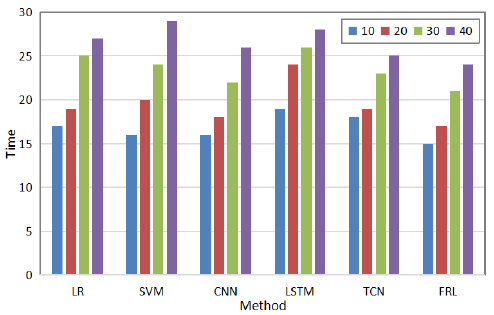
Figure 5. Comparison of detection times of different